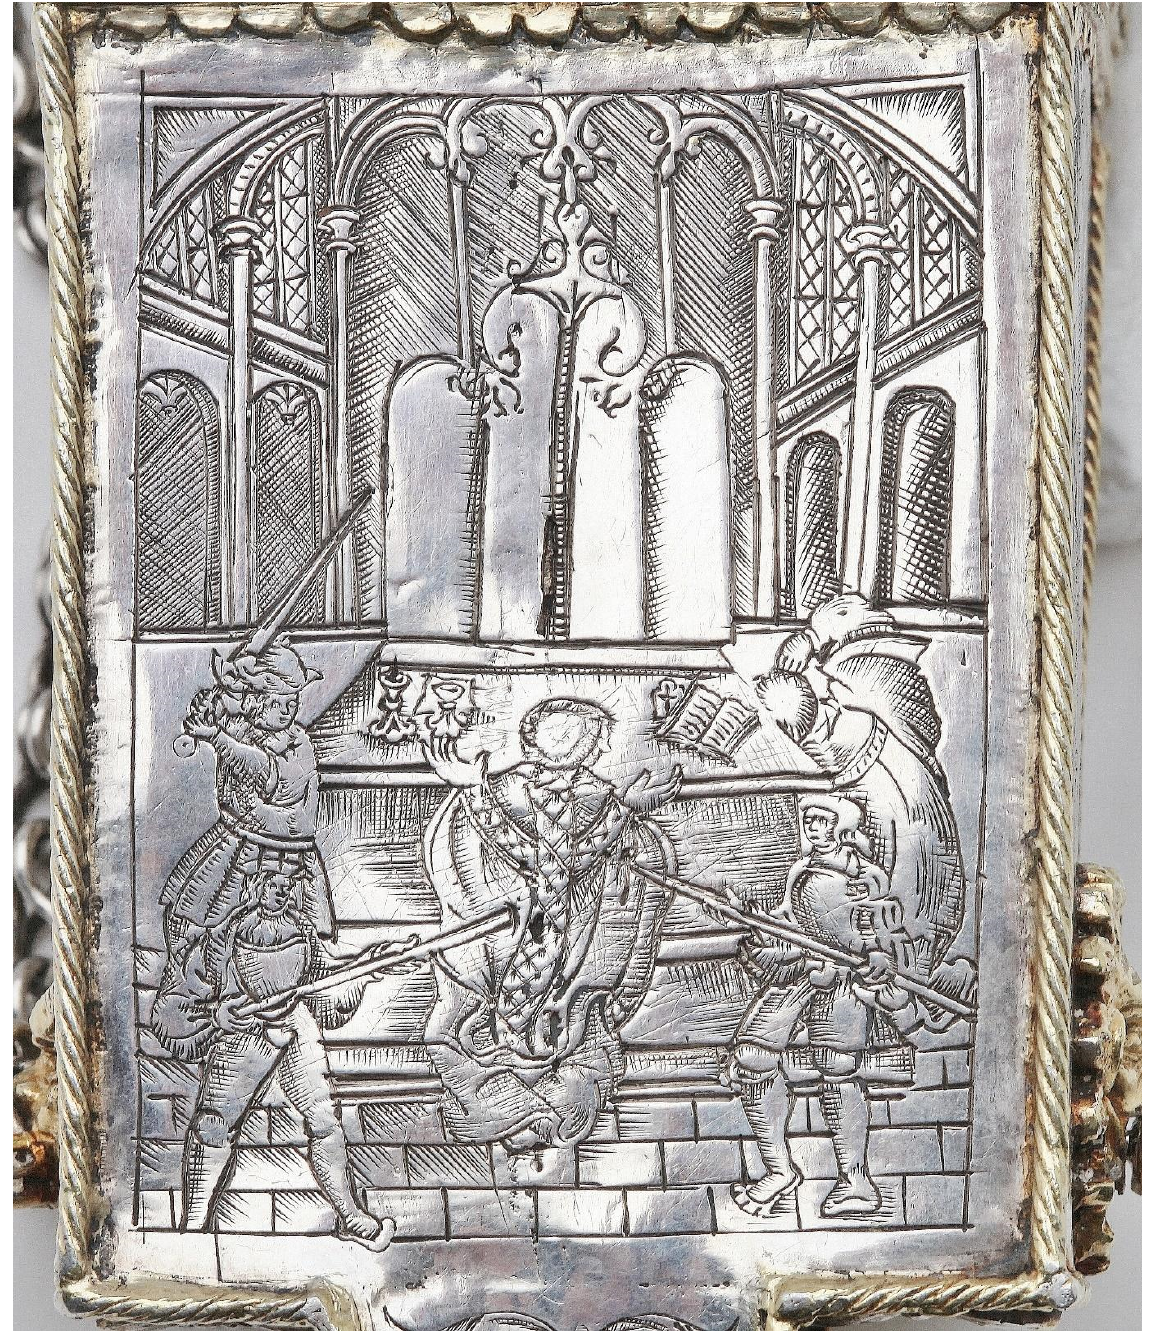
Figure 8. Closeup of the Thomas Becket panel from the centre of the Barber Surgeon’s instrument case. Worshipful Company of Barbers .